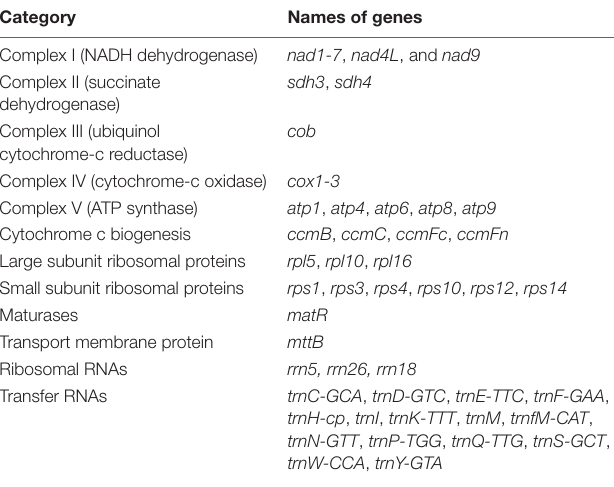
TABLE 3 | Annotated genes in the mitochondrial genomes of T. esculentum